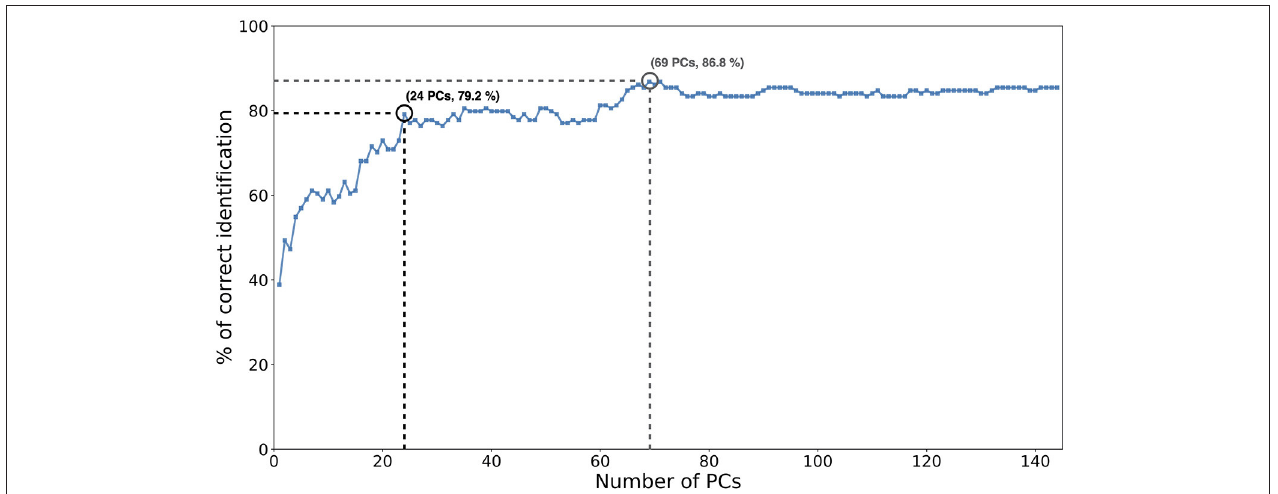
FIGURE 5 | Correct identifications of the model from POST motion, as a function of the number of principal components (PCs), used. The first 24 PCs contributed to most of the correct identifications of the model (79.2%). The highest accuracy (86.8%) was obtained with 69 PCs.